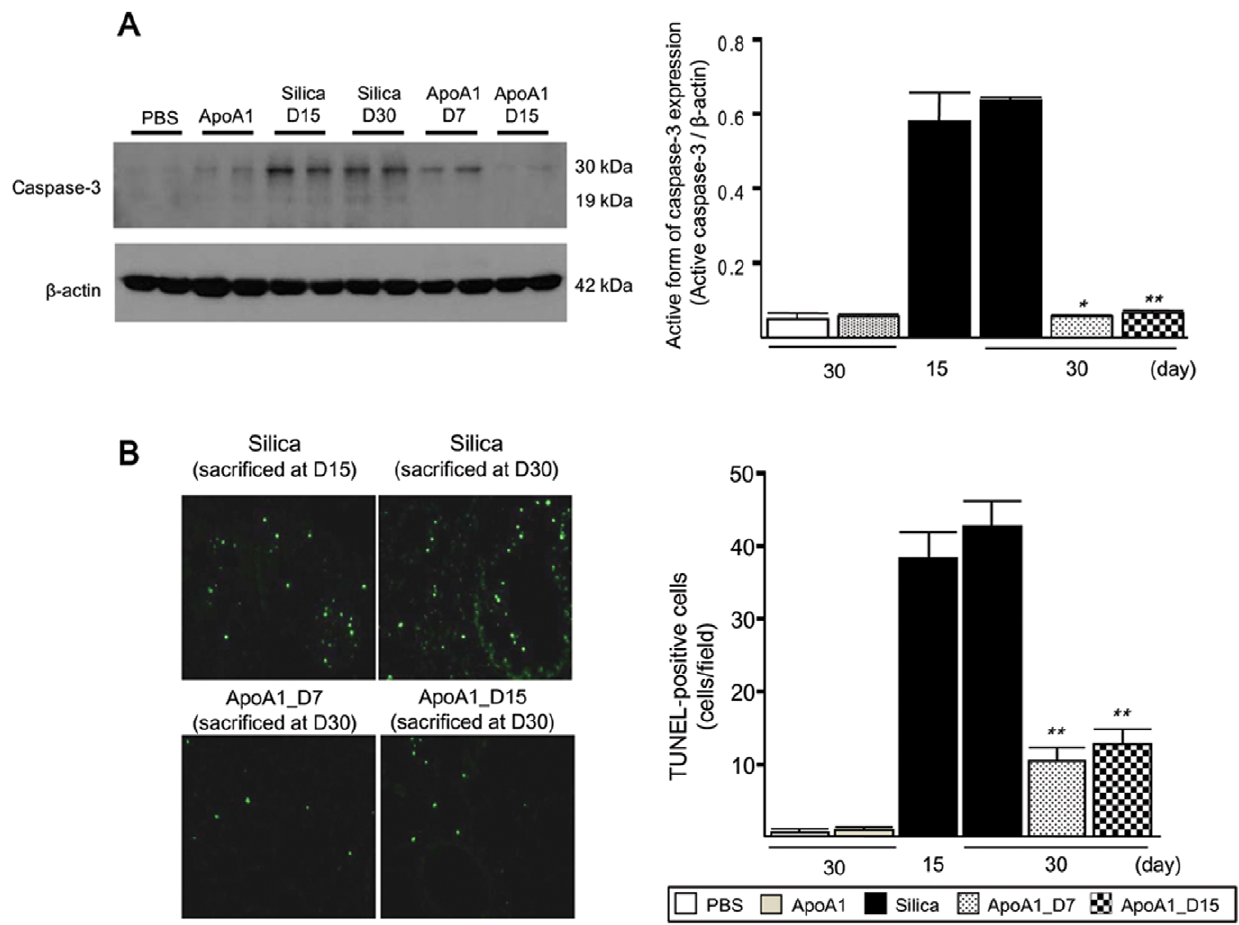
Figure 6. Quantification of silica-induced apoptosis in the lungs of the ApoA1 transgenic mice. ( A) Immunoblot analysis showed that active form of caspase-3 protein expression was significantly decreased in the ApoA1_D7 and D15 groups compared with the Silica group. ** p , 0.01 compared with the Silica group (D30). * p , 0.05 compared with the Silica group (D30). (B) Tissues stained by the TUNEL method were observed at 6 100 magnification, and the number of TUNEL-positive cells in a minimum of 20 fields per lung was counted ( n =8 mice/group). ** p , 0.01 compared with the Silica group (D15 and D30).